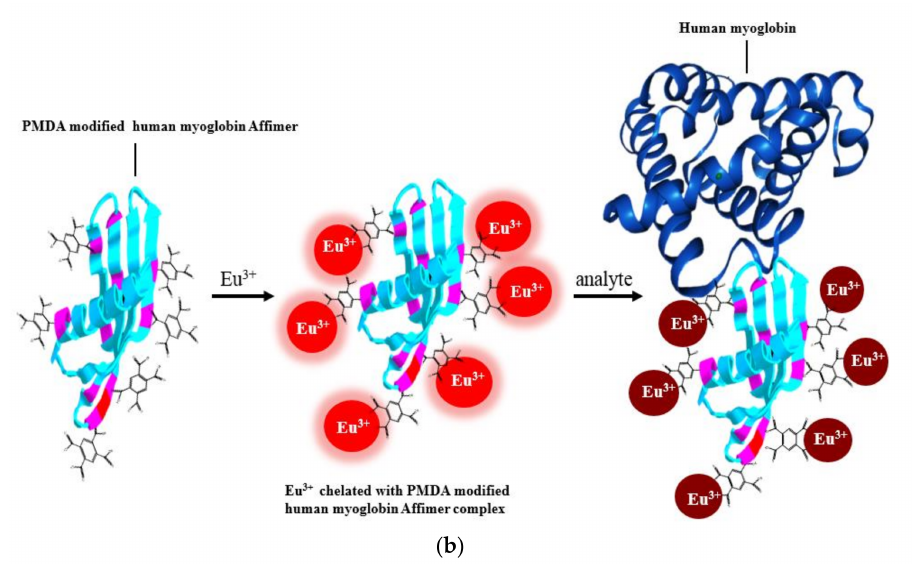
Figure 2. Schematic showing reaction of PMDA with lysine on the Affimer and the analyte binding. ( a ), Affimers were functionalised by conjugating PMDA to the scaffold. The modification forms a peptide bond between carboxylic groups on the PMDA to the Affimer lysines, whilst the other PMDA anhydride becomes hydrolyses, providing two additional carboxy groups. ( b ), the analyte (human myoglobin) binds to the Affimer variable loops and thereby partially shields the chelated Eu 3+ from